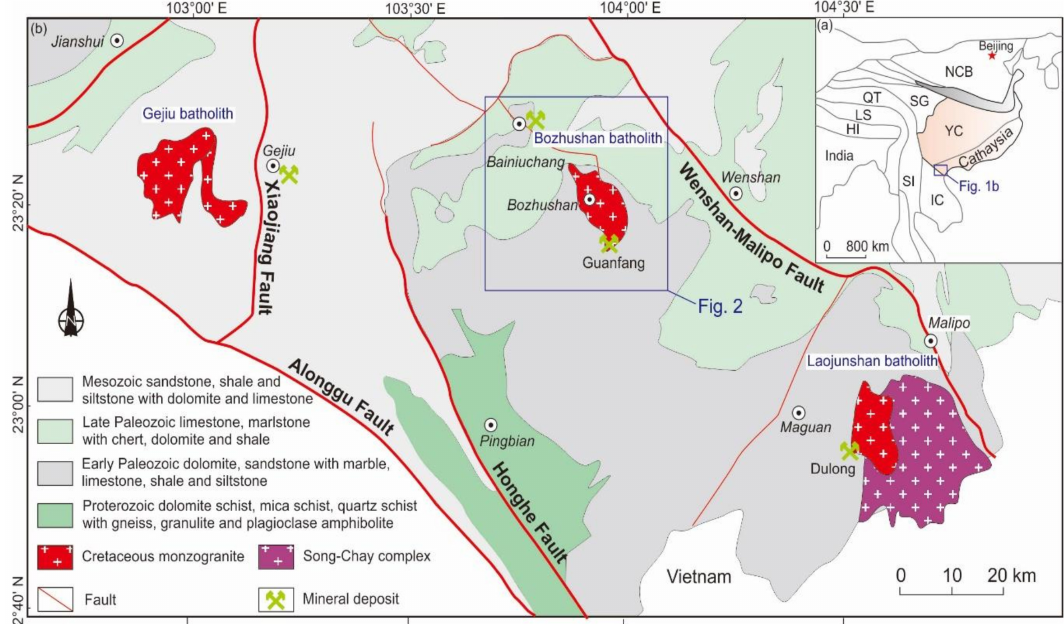
Figure 1. ( a ) Geological location of the studied area; ( b ) schematic map of southeastern Yunnan ore district, showing the distribution of Cretaceous batholiths and associated mineral